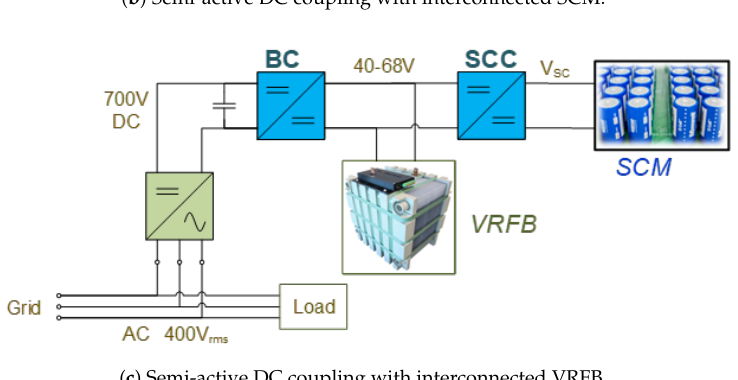
Figure 3. Three possible configurations for HESS coupling